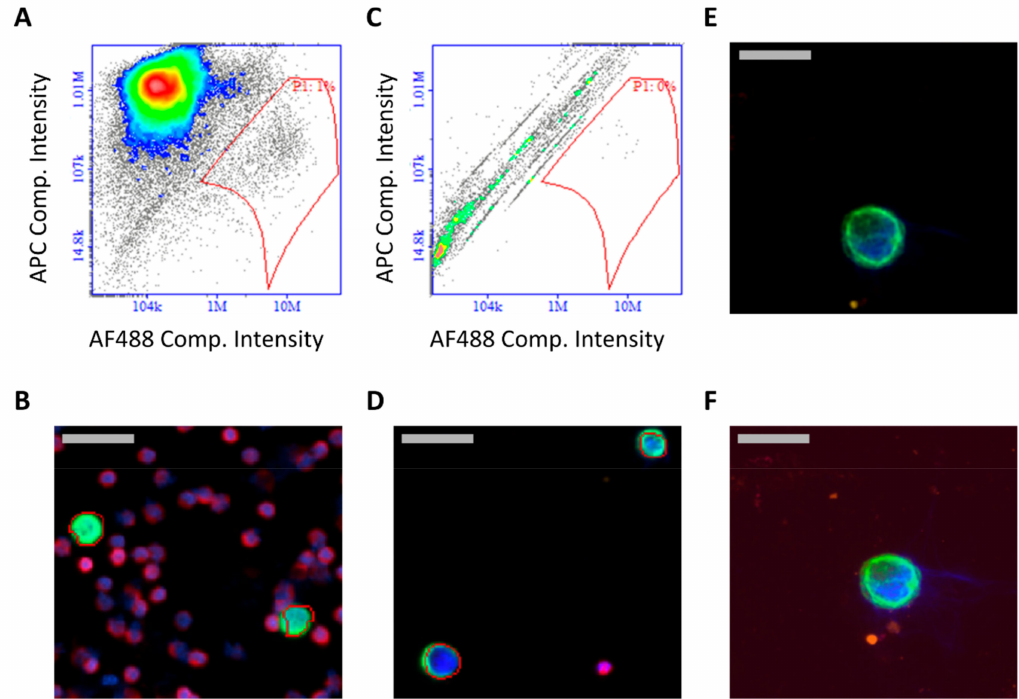
Figure 4. Semi-automated CTC evaluation using the XCyto ® 10 imaging system. ( A ) Image of the plot used for setting up a suitable gating to distinguish tumor cells from PBMCs. APC intensities (CD45 on leukocytes) of individual cells are plotted against their intensities in the Alexa Fluor 488 (pan-keratin on MCF-7 cells) channel. Cells with low CD45 (APC) and high pan-keratin (Alexa Fluor 488) signals were considered as tumor cells. Gate P1 was chosen so that a maximal separation of tumor cells from PBMCs was achieved. ( B ) Overlay of the P1 gate with a section of the original image. Cell nuclei were visualized with DAPI (blue), tumor cell marker pan-keratin- Alexa Fluor 488 was used (green) and CD45-APC (red) as a negative selection marker for PBMCs. Grey scale bar represents 40 µ m. ( C ) Exemplary image of the gating from a patient sample. Cells with low APC- and high Alexa Fluor 488 signals were considered as potential CTCs in gate P1. ( D ) Overlay of positive hits of the P1 gate with a section from the original image. Grey scale bar represents 40 µ m. ( E ) CTC from patient sample no. 13 imaged with 2 di ff erent settings. Above: CTC imaged with 40 × objective of Axioplan2 (Zeiss) microscope. Grey scale bar represents 20 µ m. ( F ) The same cell was imaged with XCyto ® 10 (20 × objective). Grey scale bar represents 20 µ